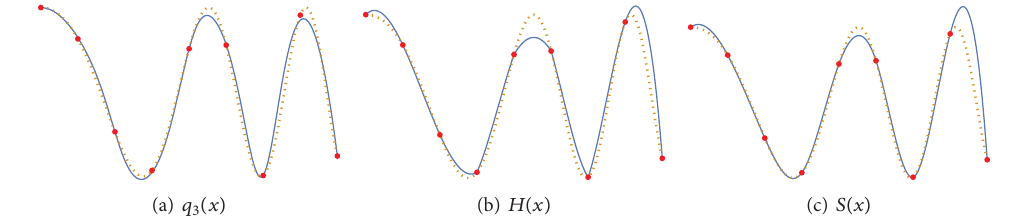
Figure 5: Comparison of the presented approximation 𝑞 3 (𝑥) , Hermite interpolation 𝐻(𝑥) , and spline interpolation 𝑆(𝑥) for 𝑓(𝑥) with 𝑁 = 2 3 . Dotted curves indicate the original graph of 𝑓(𝑥) .